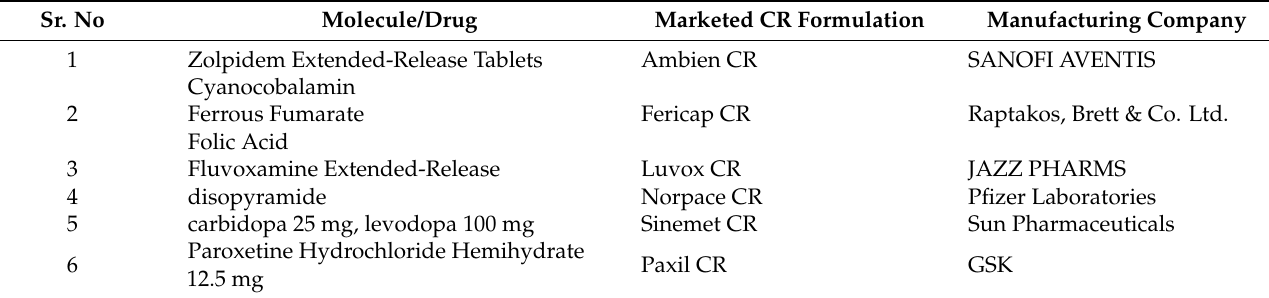
Table 6. Summary of some marketed CR